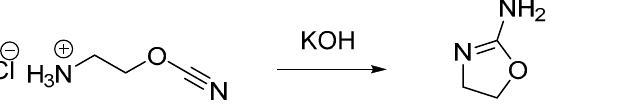
Figure 2. Synthesis of the first reported 2-oxazoline monomer derivative: 2-amino-2-oxazoline.